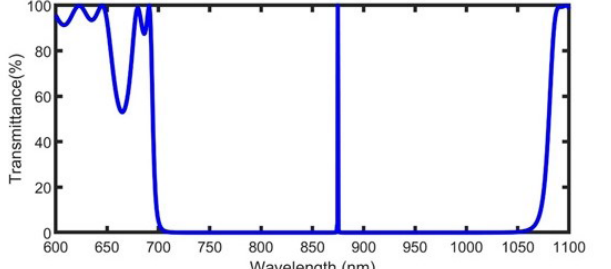
Figure 2. Transmittance spectra of defected 1DPC with a normal blood sample (TBN) at N=7, incident angle 0 0 θ= , and the thickness of defect layer d =209 3